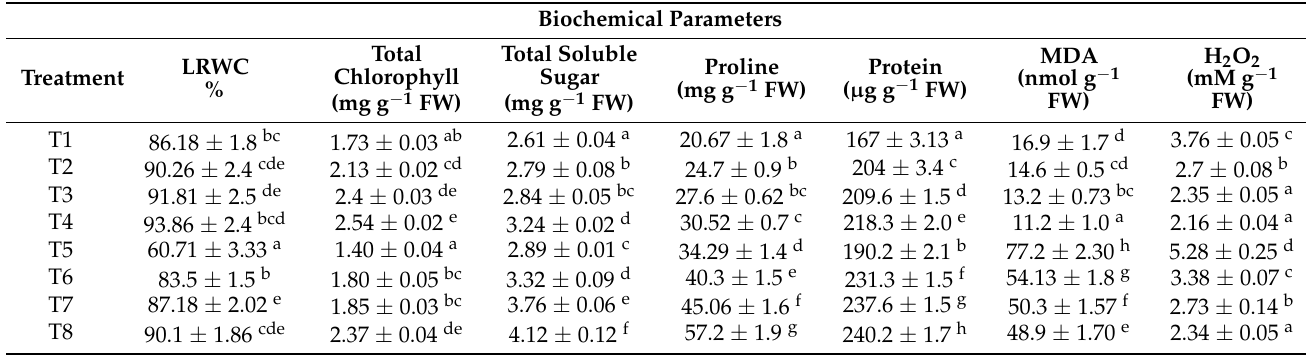
T2— Bacillus cereus (AKAD A1-1), well-watered; T3— Pseudomonas otitidis (AKAD A1-2), well-watered; T4— Pseudomonas sp. (AKAD A1-16), well-watered; T5—control (uninoculated), with drought stress; T6— Bacillus cereus (AKAD A1-1), with drought stress; T7— Pseudomonas otitidis (AKAD A1-2), with drought stress; T8— Pseudomonas sp. (AKAD A1-16), with drought stress.